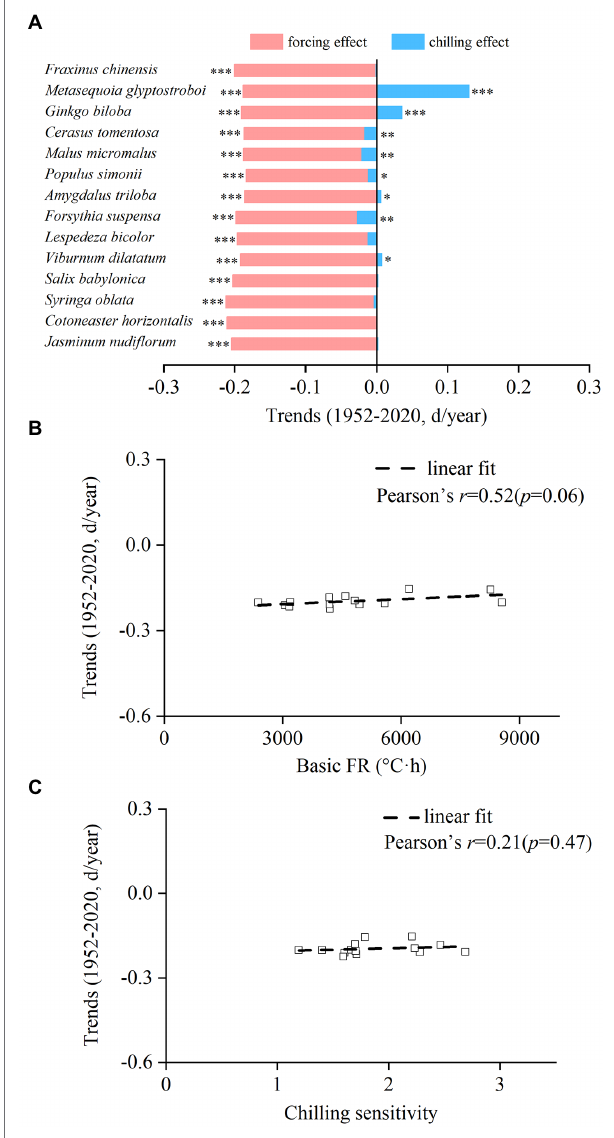
FIGURE 5 | Interspecific difference in trends of the chilling effect and forcing effect on spring events from 1952 to 2020. (A) Trends of the chilling effect and forcing effect for each species. (B) Relationship between the trends of spring events and basic forcing requirement (basic FR). (C) Relationship between the trends of spring events and chilling sensitivity. *** p < 0.001; ** p < 0.01; * p <